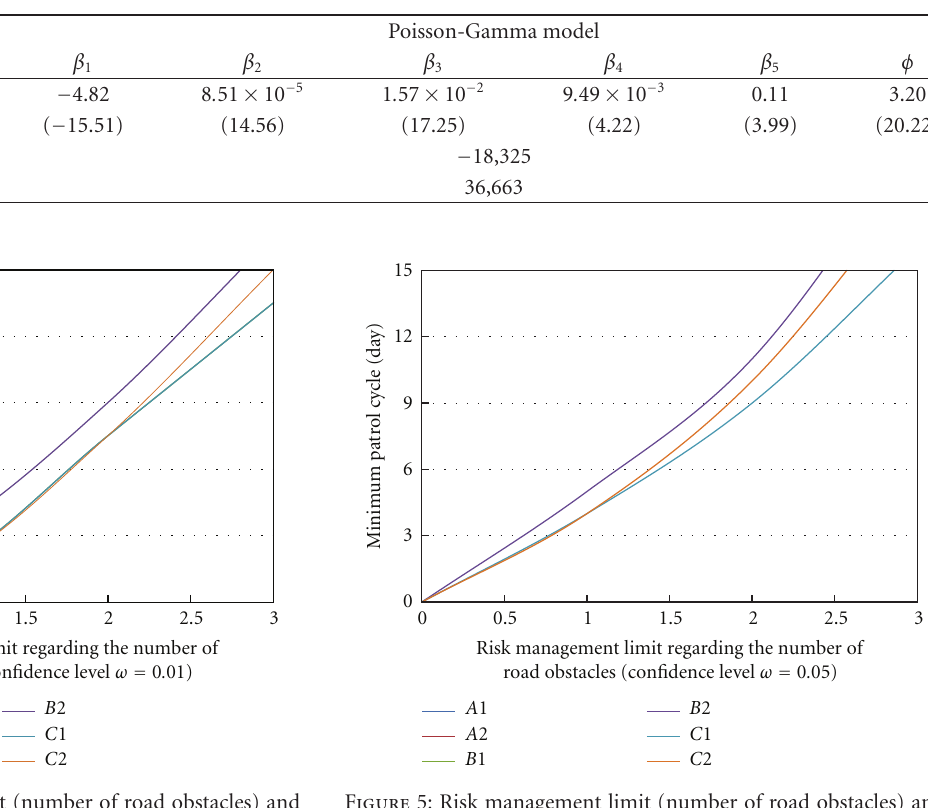
Table 2: Estimation results of the Poisson-Gamma model.